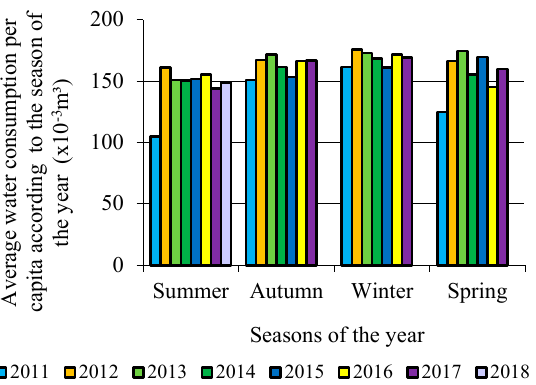
Figure 6. Average daily consumption per capita, based on annual consumption data (it does not include water consumption in toilets).